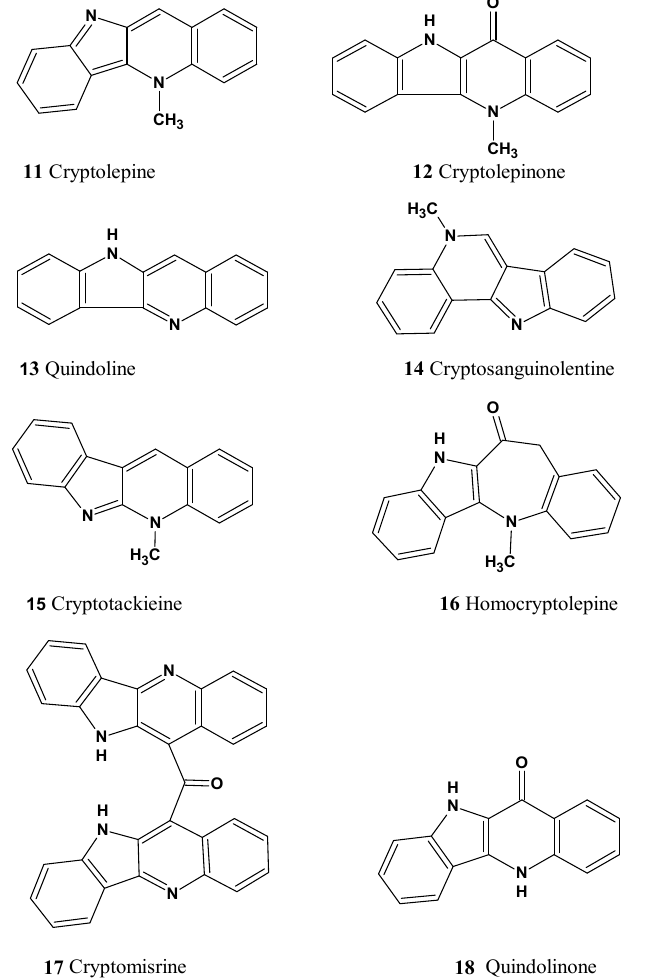
Figure 14. Alkaloids of the cryptolepine family used for creation of the User Fragment Database.